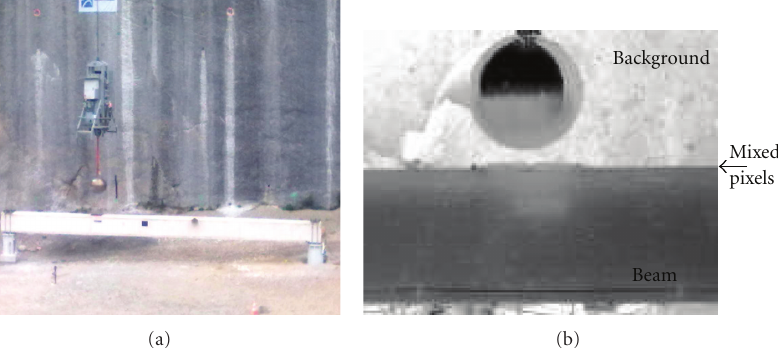
Figure 1: (a) Picture of the experimental site with the heavy load (iron ball) suspended at the height of 1m over the beam. (b) Example of a frame acquired by HFI FLIR camera. The frame depicts the heavy load just before the impact on the concrete beam. The black arrow indicates the mixed pixels (i.e., background and beam) used for calculating the oscillation frequency after the impact.